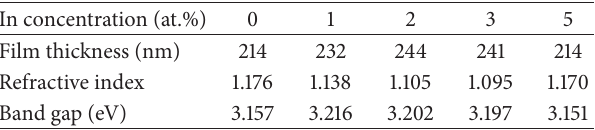
Figure 1: XRD patterns of ZnO:In films with different dopant concentrations (0–5 at.%). The inset is the plot of the (002) peak position as a function of indium doping concentration. Table 1: Film thickness, refractive index, and band gap of ZnO:In films with different doping